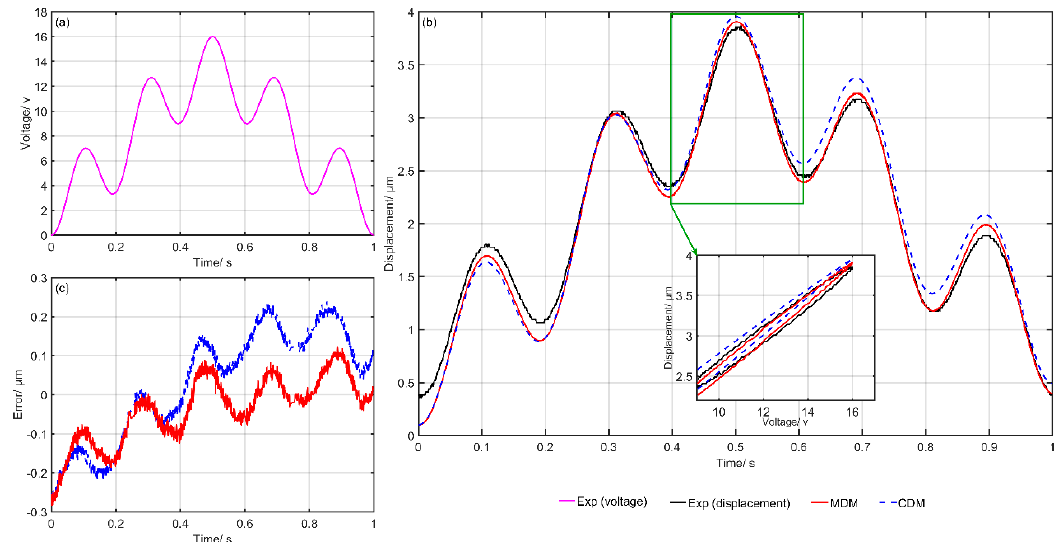
Figure 9. Exp4: Comparison of the experimental and simulation results of the CDM and MDM under u 4 ( t ) = 5sin ( 2 π · t ) + 3sin ( 2 π · 5 t ) + 8: ( a ) Time histories of input voltage, ( b ) time histories of output displacements and ( c ) time histories of errors of the CDM and MDM.